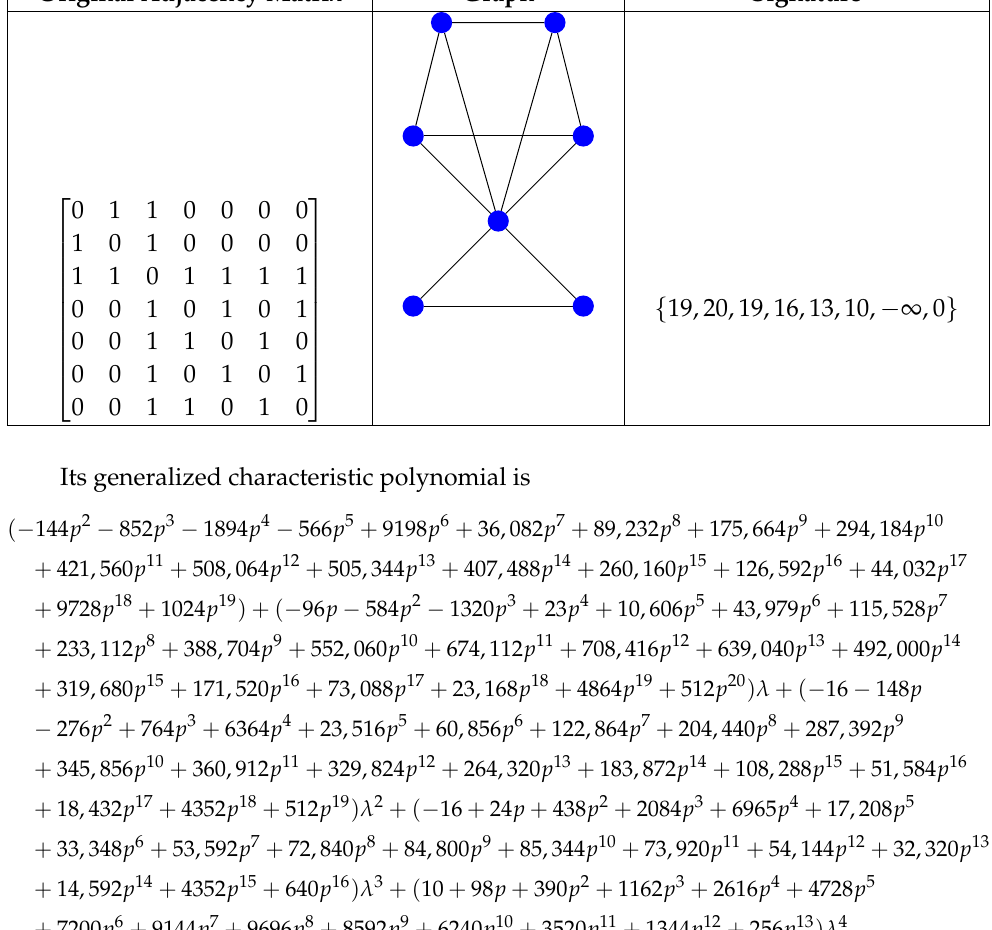
Table A3. Figure 5. Original Adjacency Matrix